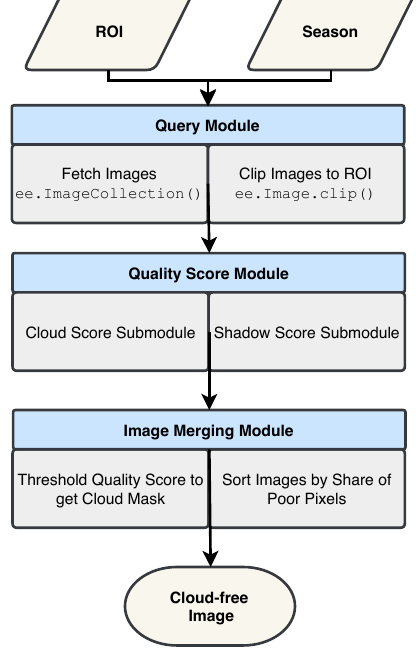
Figure 1. Workflow of the GEE-based procedure for cloud-free Sentinel-2 image generation presented in (Schmitt et al., 2019). three main modules, which are carried out for every ROI. These ROIs result from two uniform random samplings over the land- masses of the Earth and the urban areas across the globe, respec-